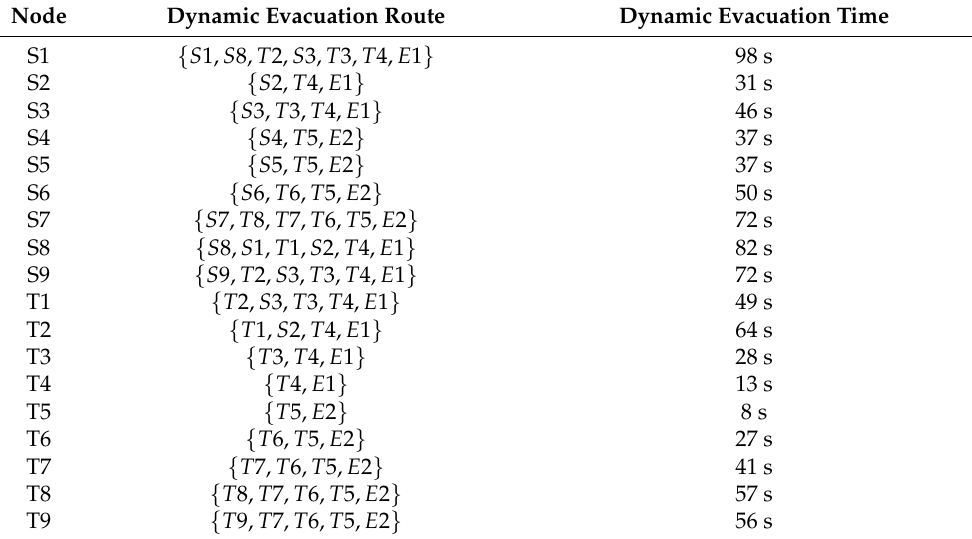
Table 8. The dynamic evacuation route and time required for the T1 fire scenario. Node